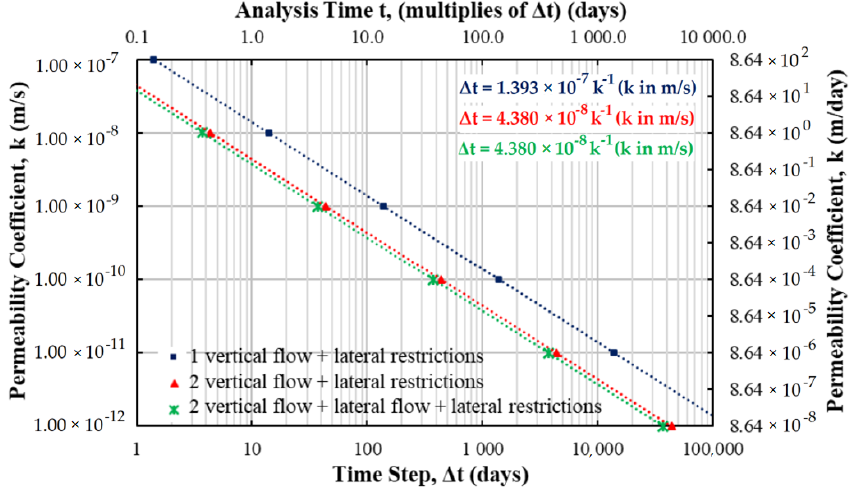
Figure A3. Calibration curves of the elastoplastic coupled model under vertical flow, no lateral flow, and lateral